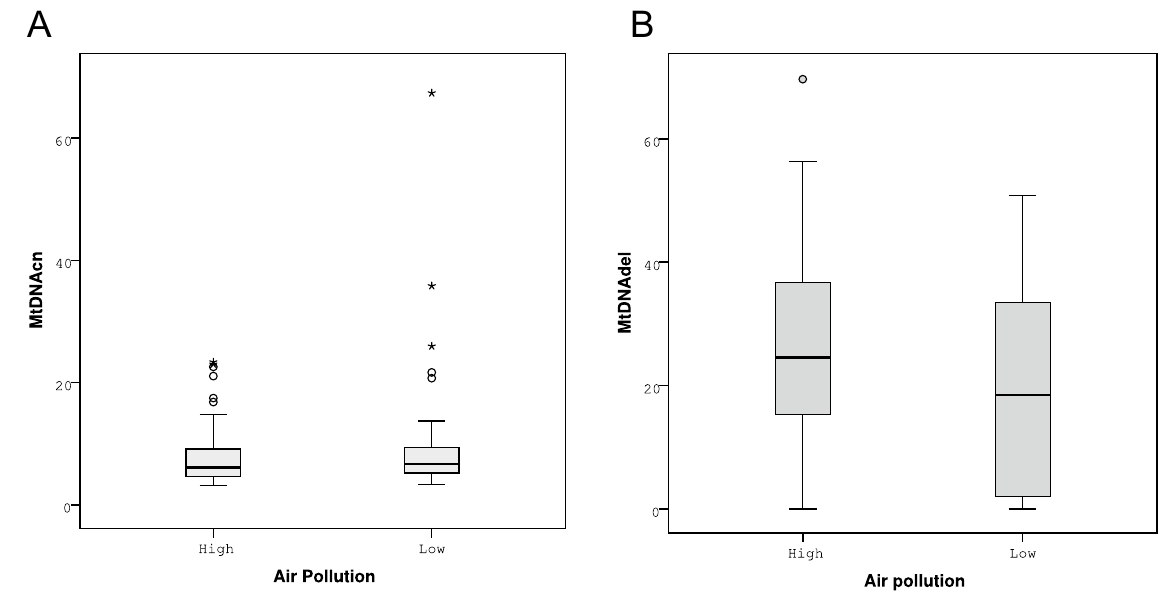
Figure 1. Comparison of sperm mtDNAcn ( A ) and mtDNAdel rates ( B ) following the high (winter) and low (summer) air pollution periods. The vertical height of each box represents the range of 25–75% of the data (the interquartile range; IQR), the horizontal line within each box represents the median value, and the upper and lower extensions represent the largest and smallest values that were determined to not be outliers. The open circles ( ○ ) denote simple outliers, i.e., samples that fell more than > 1.5 IQR from the 25th percentile of the distribution, whereas asterisks (*) denote extreme outliers, i.e., samples that fell > 3 IQR from the 25th percentile of the